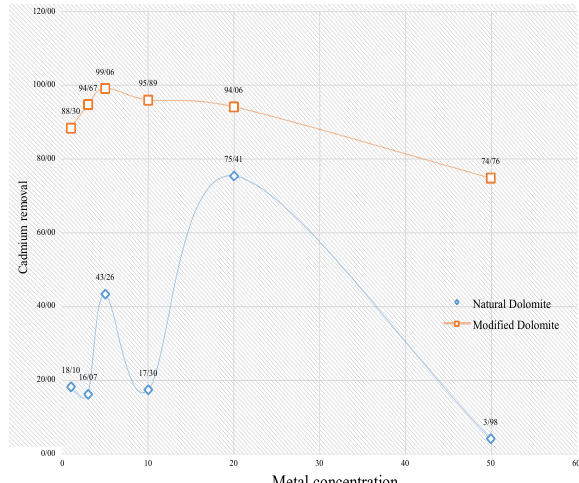
Fig. 11. Comparison of the removal percentage of cadmium from the solution for certain concentrations using natural and modified dolomite